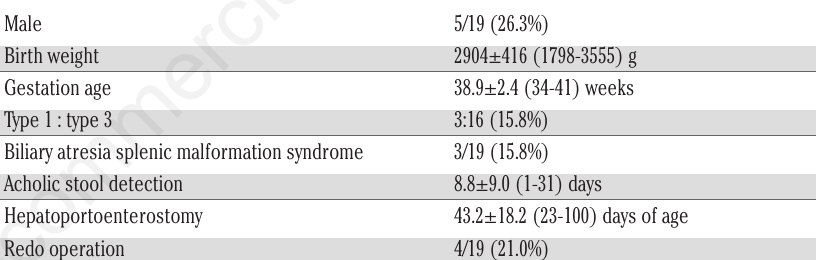
Table 1. Demographic data of 19 subjects.